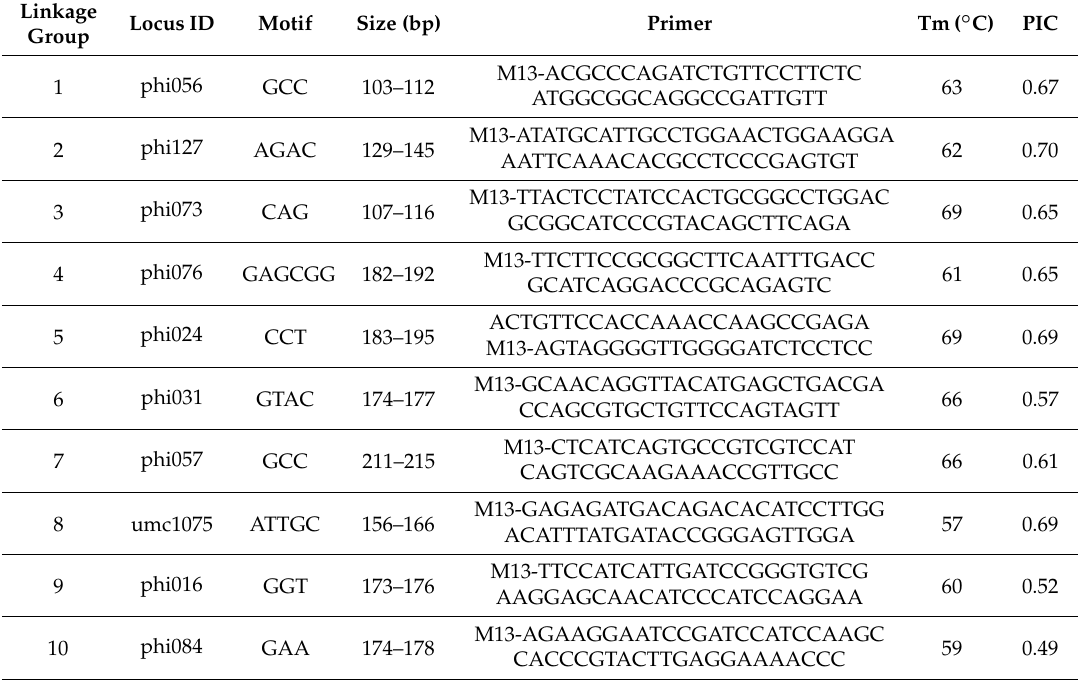
Table 1. List of SSR loci selected from Register et al. [23] for use in this study. For each microsatellite locus, linkage group, locus ID, motif, amplicon size in bp, forward and reverse primer sequences used to amplify the microsatellite region, melting temperature and polymorphism information content (PIC) coefficient related to the previously mentioned study are